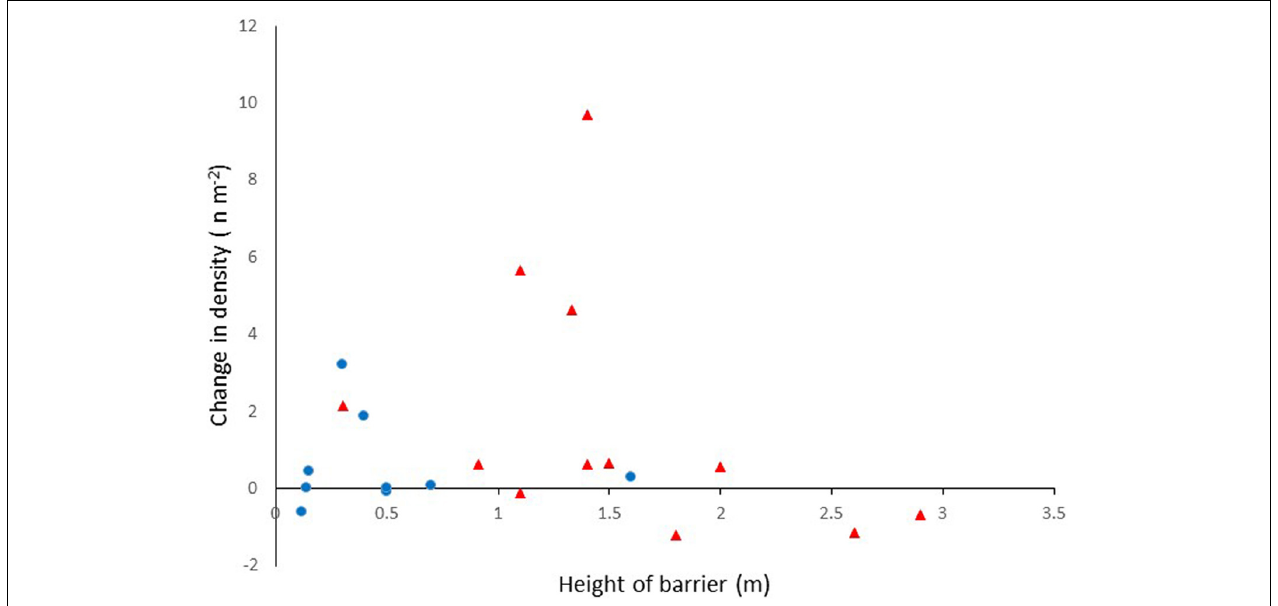
FIGURE 4 | Change in total fish density following barrier removal. Red triangles depict DK sites; blue circles depict UK sites.